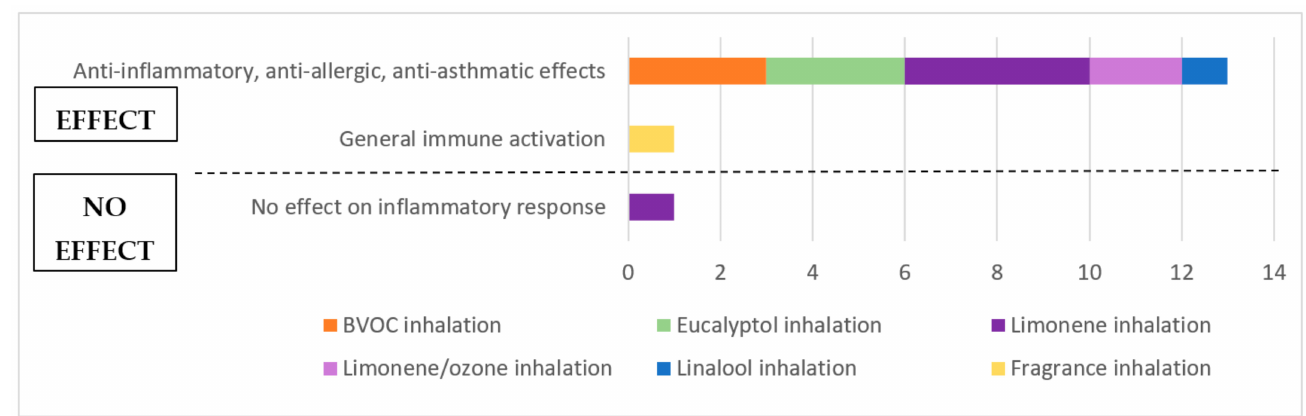
Figure 3. Overview of outcomes from animal